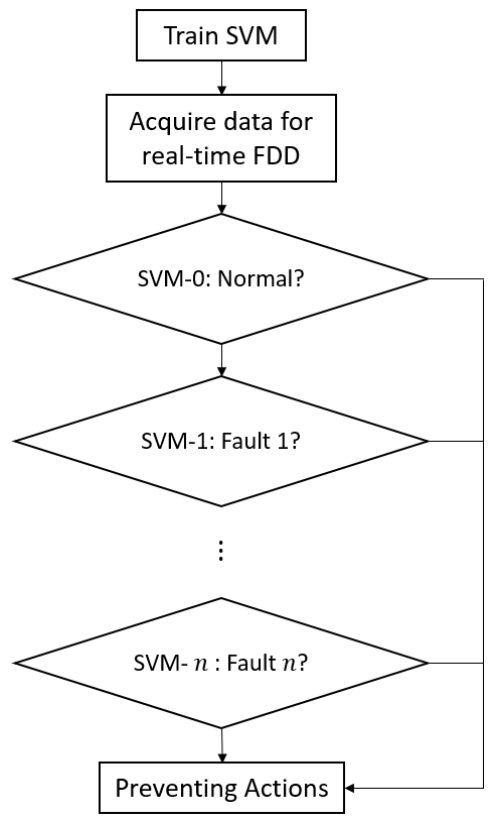
Figure 3. One-vs-all SVM classification procedure (simplified from [51]).